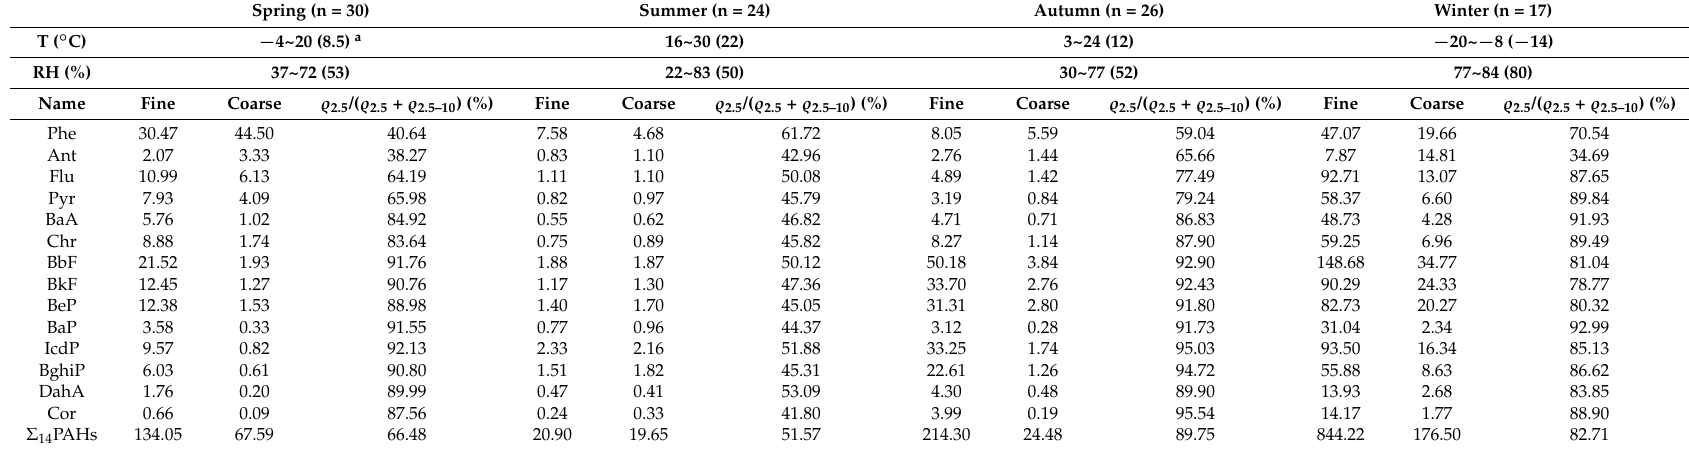
Table 1. Mean particulate PAH mass concentrations in PM 2.5 and PM 2.5–10 (ng m − 3 ) and the proportion of (cid:36) 2.5 /( (cid:36) 2.5 + (cid:36) 2.5–10 ). (n = sample